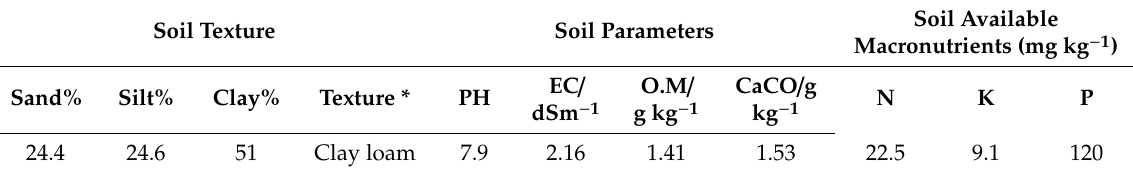
Table1. Physicalandchemicalpropertiesoftheusedsoilfortransplantingtomatoseedlings( Lycopersicon esculentum Mill cv. Super Strain